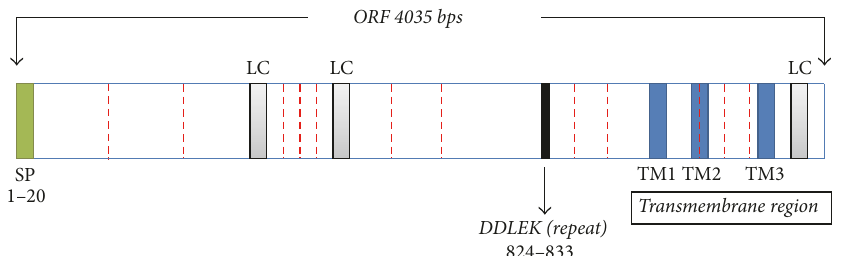
Figure 1: Schematic representation of Babesia orientalis RON2 gene with an open reading frame of 4035 bps length, signal peptide is shown is green (1–20), the three transmembrane (TM) domains are shown in blue, in grey are the predicted low complexity (LC) regions, and in red are the twelve cysteine residues contained in that gene. The repeat motif is shown in black between the amino acid regions 824 and